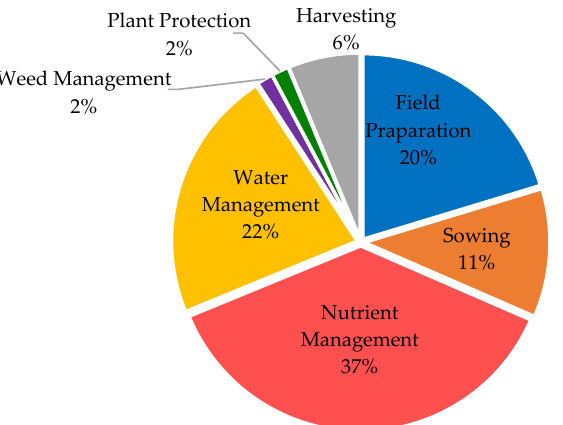
Figure 10. Operation-wise mean share of carbon emission for the cultivation of fodder maize (mean of two years).